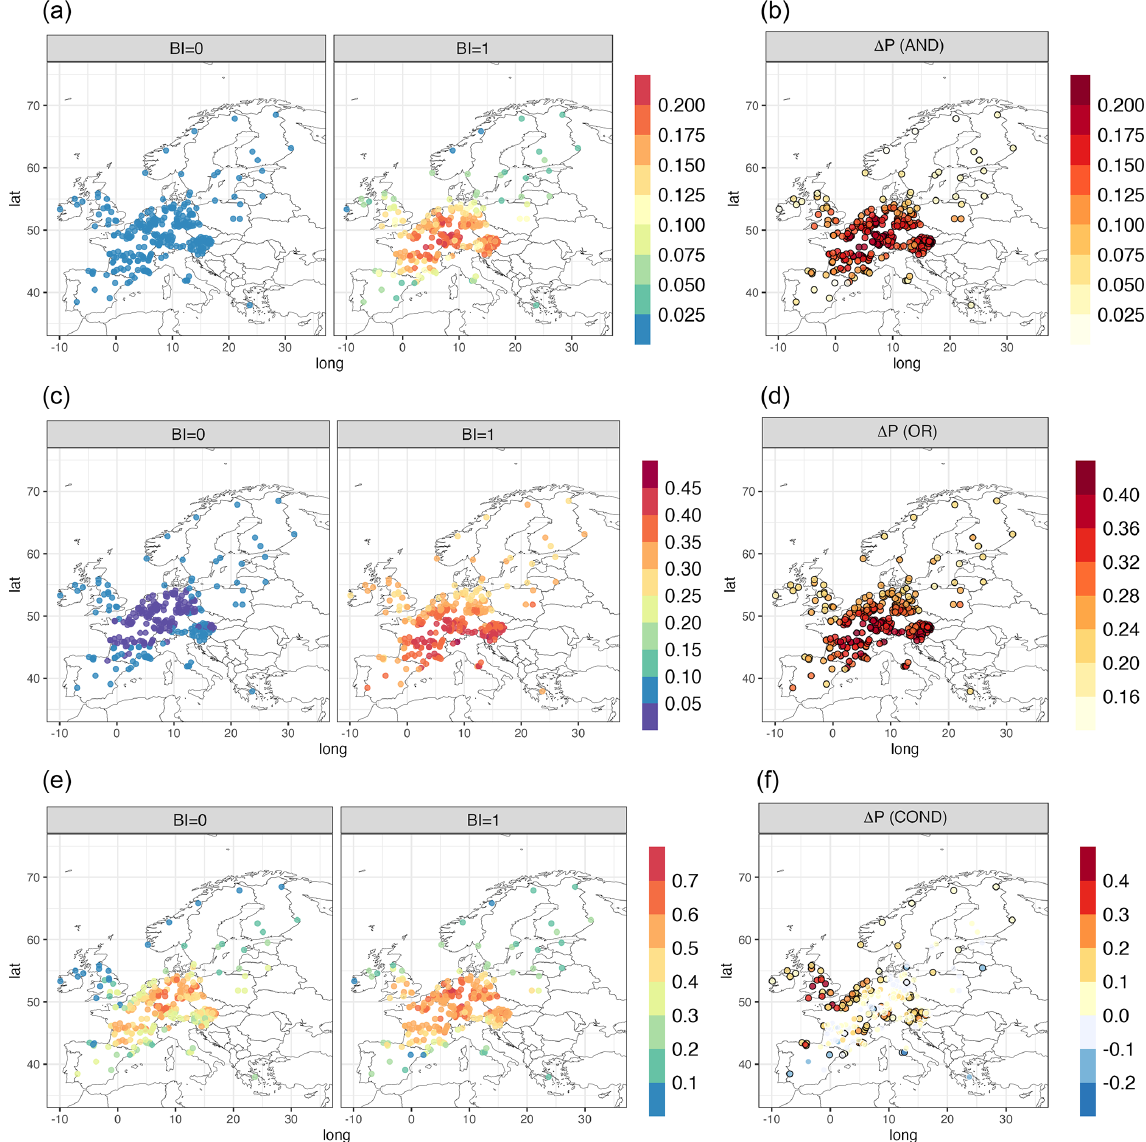
Figure 6. Probability scenarios AND (a, b) , OR (c, d) and COND (e, f) derived from the copula analysis when BI = 1 and BI = 0 (a, c, e) . (cid:49)P (b, d, f) shows the difference between the probabilities when BI = 1 and BI = 0. Black contours in (b) , (d) and (f) represent locations with statistically significant differences at the confidence level of